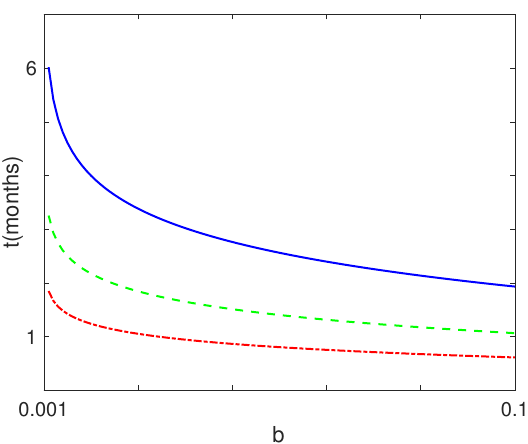
Fig. 4 Plot of the depth of resection b versus the recurrence time t for different values of the proliferation rate: ρ = 1 / 5 (blue solid line), ρ = 1 / 4 (green dashed line) and ρ = 1 / 3 (red dotted-dashed